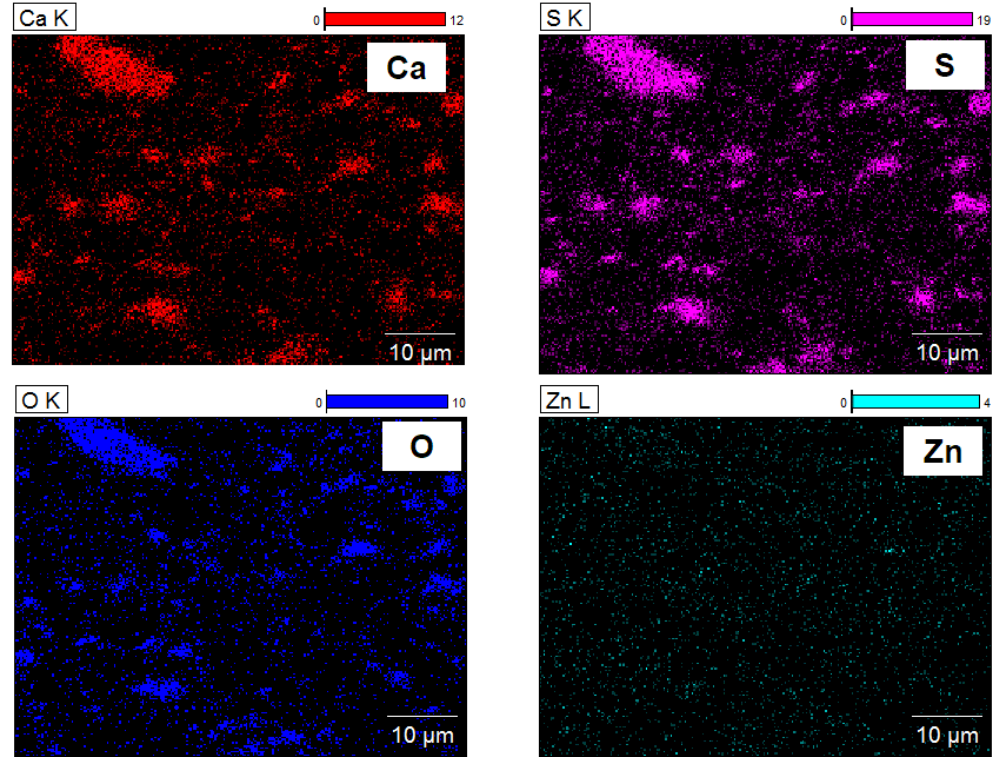
Figure 8. SEM-EDX mapping on the surface of cryo-fractured PP – AII – ZnDA composites to highlight the distribution within the PP matrix of main elements from filler (Ca, S, and O) and of Zn from ZnDA.